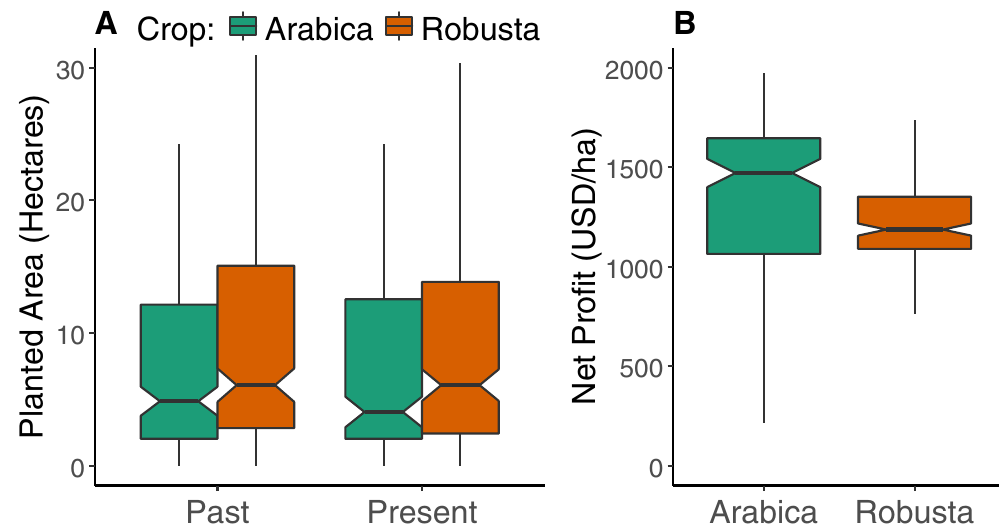
Figure 1. ( A ) Changes in planted area for arabica and robusta among the surveyed households. Notched boxplots of planted area a decade ago and during the studied period for both crops. ( B ) The net profits for each crop (in 2013 USD$) per unit hectare. After subtracting the cost of inputs per hectare, arabica was more profitable than robusta on average.